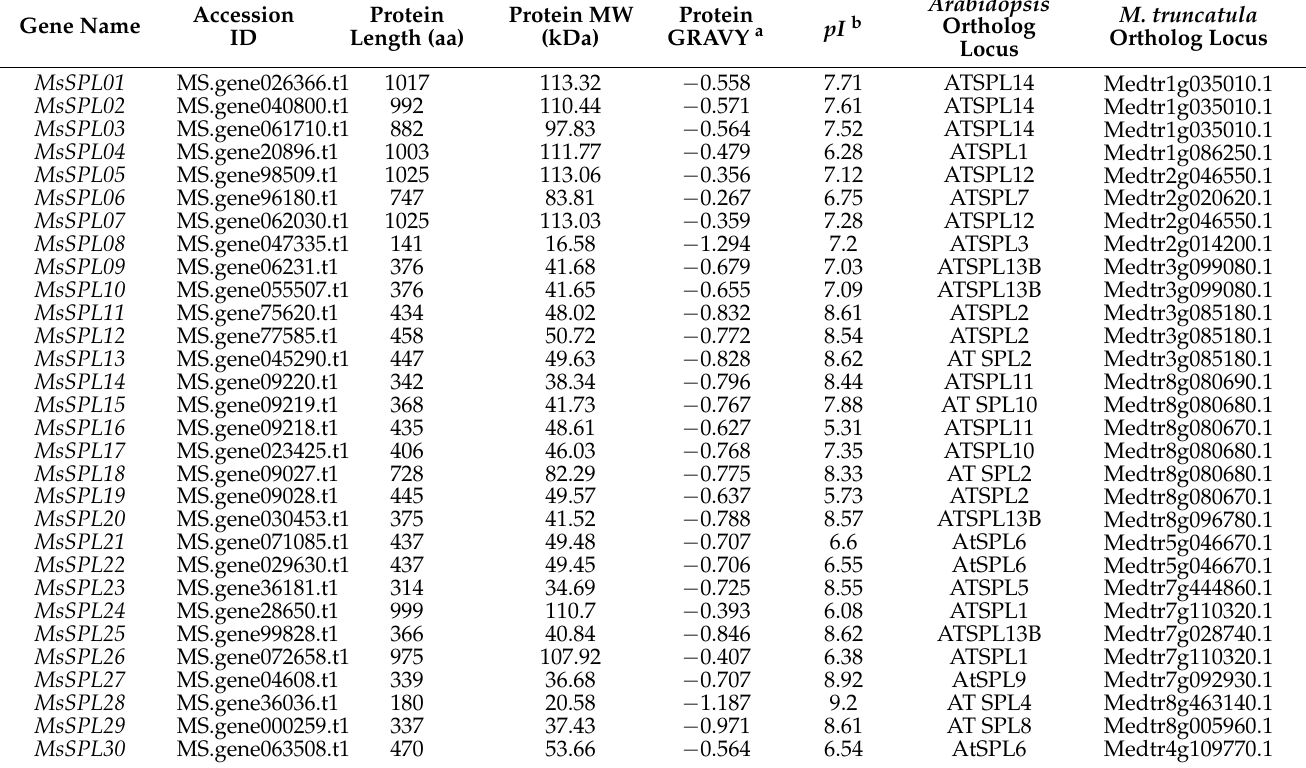
Table 2. MsSPL genes identified in alfalfa and their sequence